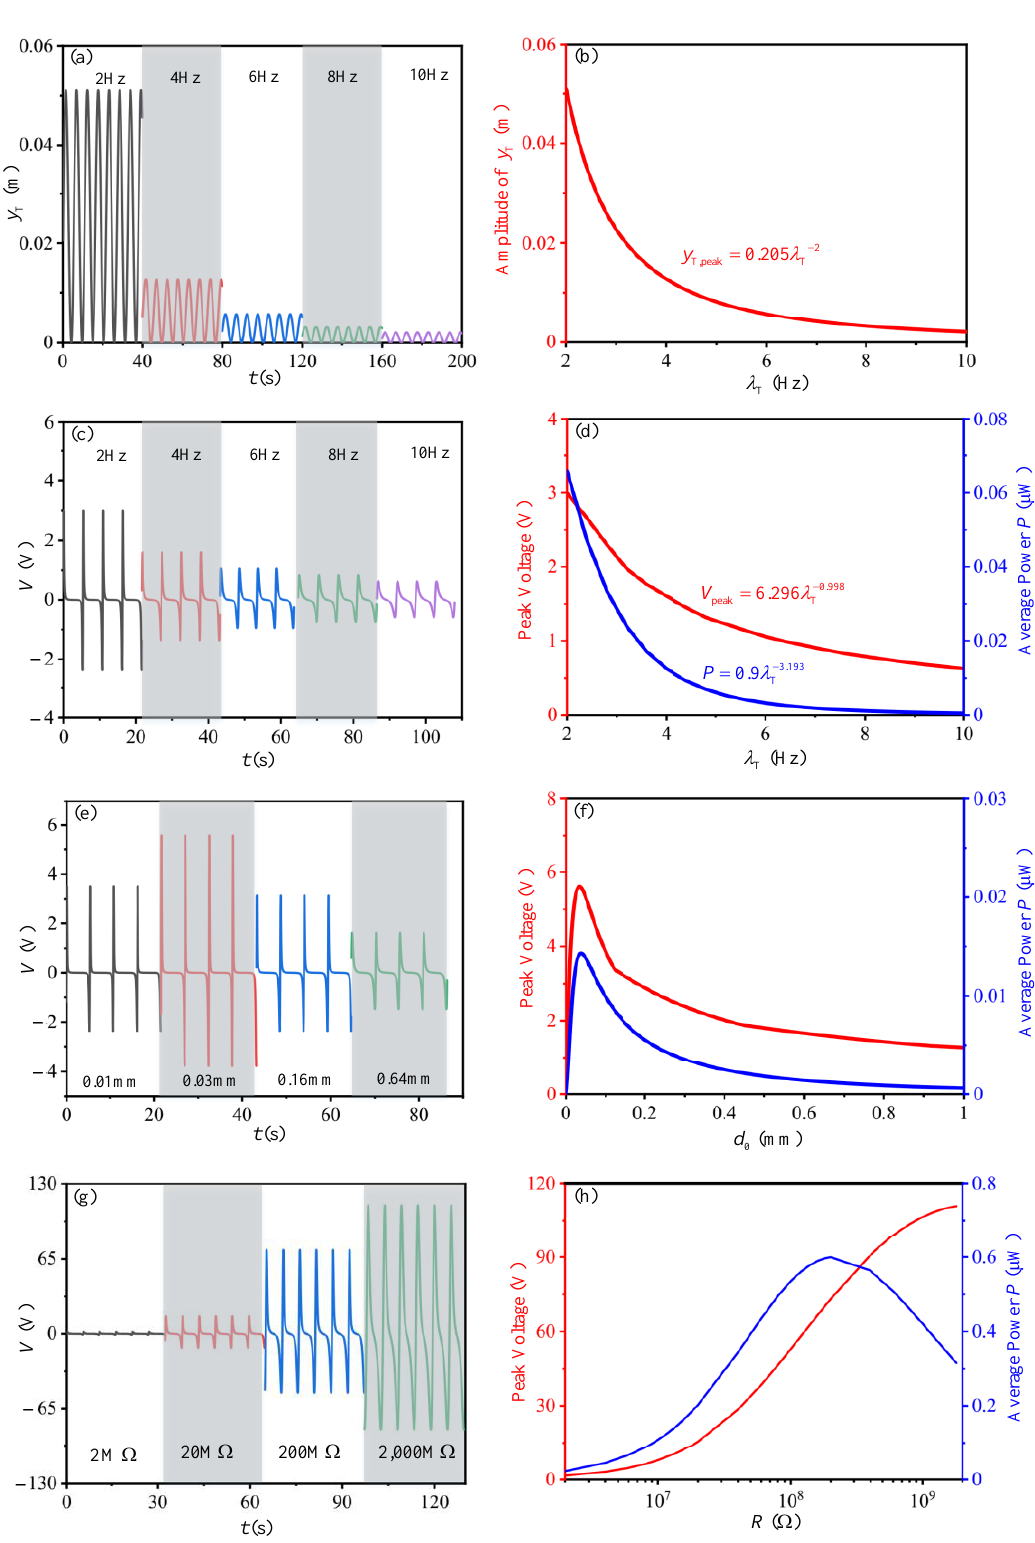
Figure 10. Influence of the natural frequency of the mass-spring bass, effective thickness of the dielectric films and the circuit resistance on the output performance of TENG device. ( a , b ) are the influence of the natural frequency of the mass-spring base on the dynamic response of the base; ( c , d ) are the influence of the natural frequency of the mass-spring base on the electric output of TENG device; ( e , f ) are the influence of the effective thickness of the dielectric layer on the electric output of TENG device; ( g , h ) are the influence of the circuit loading resistance on the electric output of TENG